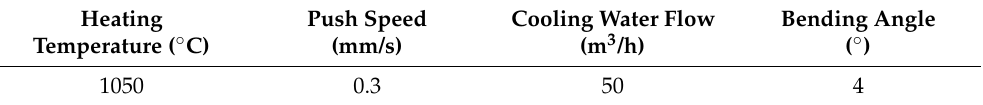
Figure 1. ( a ) parent pipe of seamless bend, ( b ) heat induction bending process, ( c ) RT2-9 bogie-hearth resistance furnace used for tempering, ( d ) the schematic diagram of the heat-induced bending process, and ( e ) the location of the test sample. Table 2. Heat induction bending parameters of heavy-wall X80 × D1422 mm heat induction seamless bend.